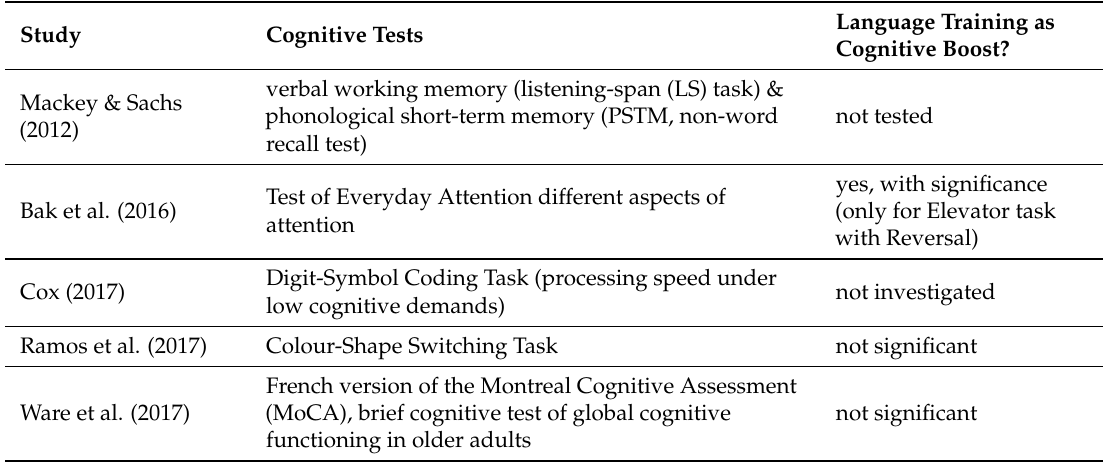
Table 3. Cognitive tasks and